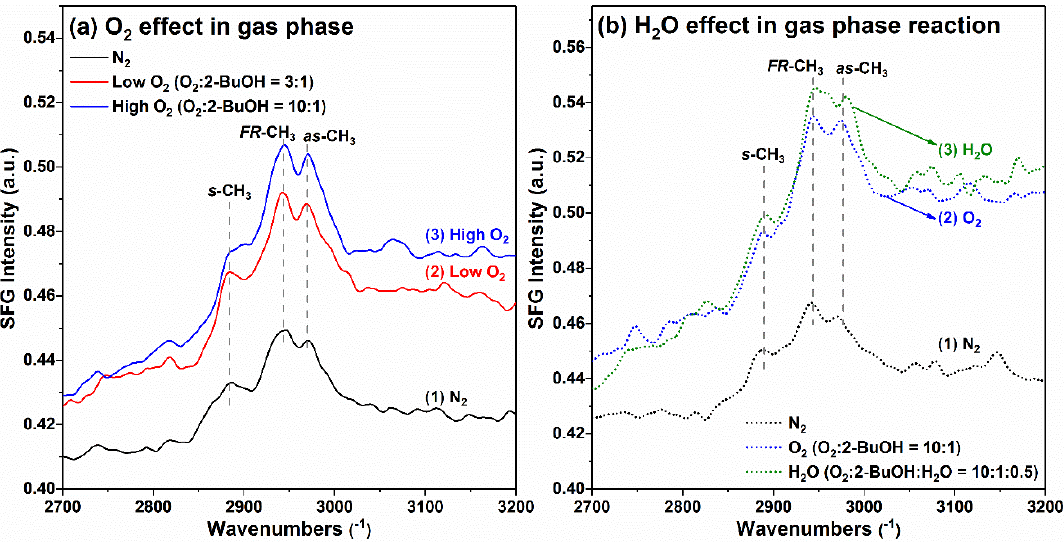
Figure 10. SFG spectra of gas phase 2-BuOH on Pt thin film at 80 °C ( a ) with varying ratios of oxygen to alcohol (i.e., N 2 only, low O 2 content with O 2 : 2-BuOH = 3:1, and high O 2 content with O 2 : 2-BuOH = 10:1), and ( b ) in the presence of water vapor (i.e., N 2 only, high O 2 content with O 2 : 2-BuOH = 10:1, and in the presence of H 2 O with O 2 : 2-BuOH: H 2 O = 10:1:0.5).